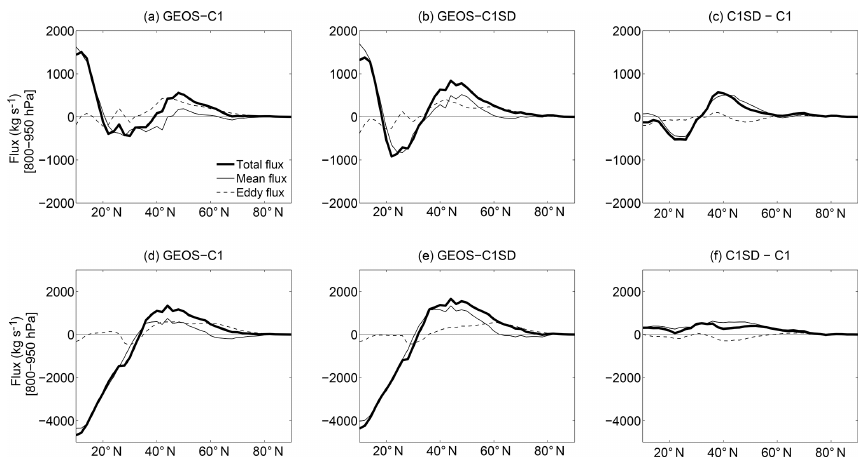
D E v (cid:48) χ (cid:48) CO50